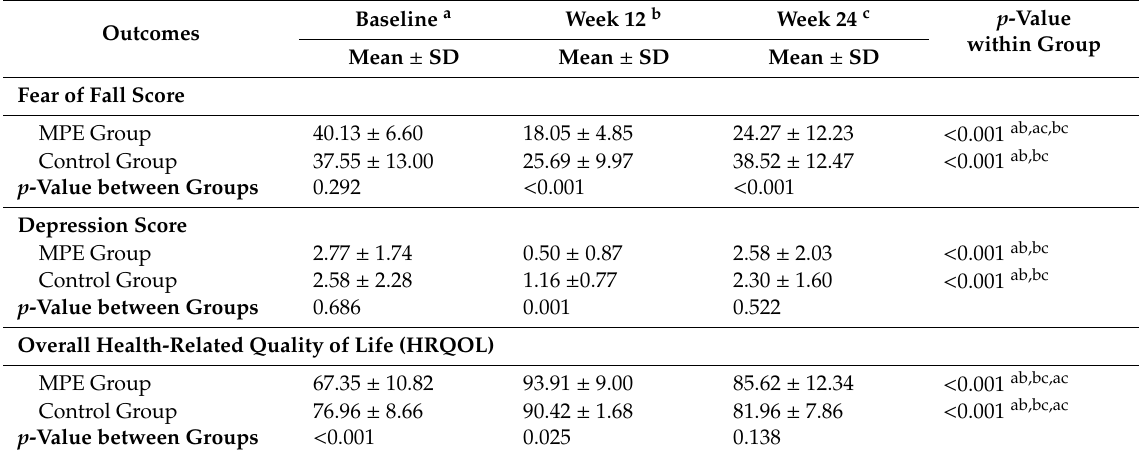
Table4. Comparisonoffearoffalling, depression,